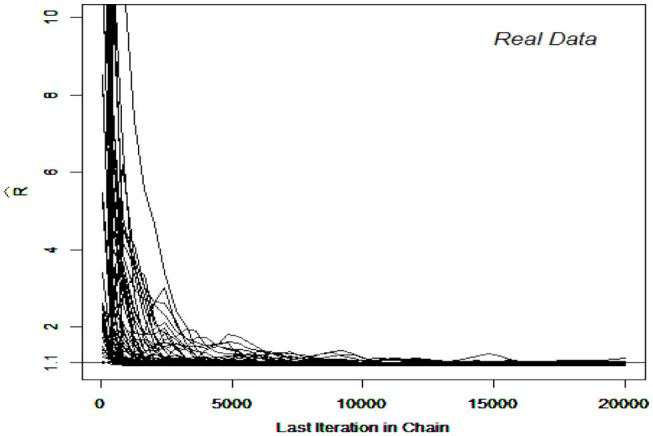
Trace Plots of R^ for the real data in the DINA model.